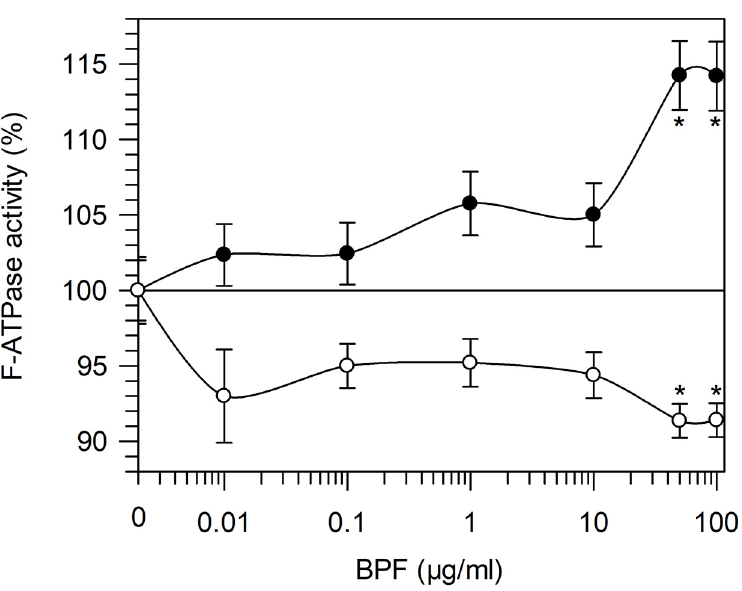
Figure 1. Dose–response curve of the BPF on F 1 F O -ATPase activity. F 1 F O -ATPase activated by Mg 2+ (Mg 2+ -activated F 1 F O -ATPase) ( ● ) and by Ca 2+ (Ca 2+ -activated F 1 F O -ATPase) ( ○ ) activities in the presence of increasing BPF concentrations are expressed as percentages of the total mitochondrial F-ATPase activity sustained by Mg 2+ or Ca 2+ , respectively. Data represent the mean ± SD from three independent experiments carried out on different mitochondrial preparations. * indicates significant differences with respect to the control ( p ≤ 0.05).